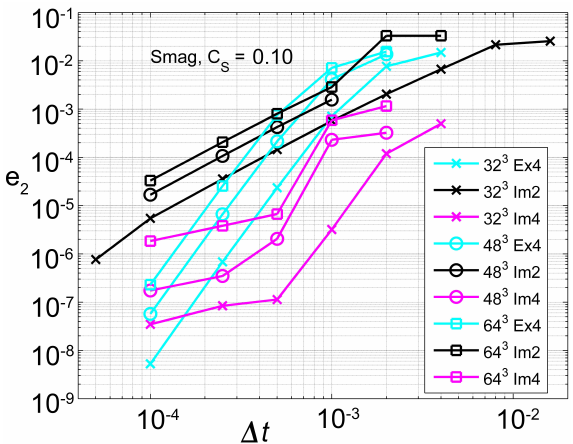
Figure 4. An error analysis based on the decay of TKE on different